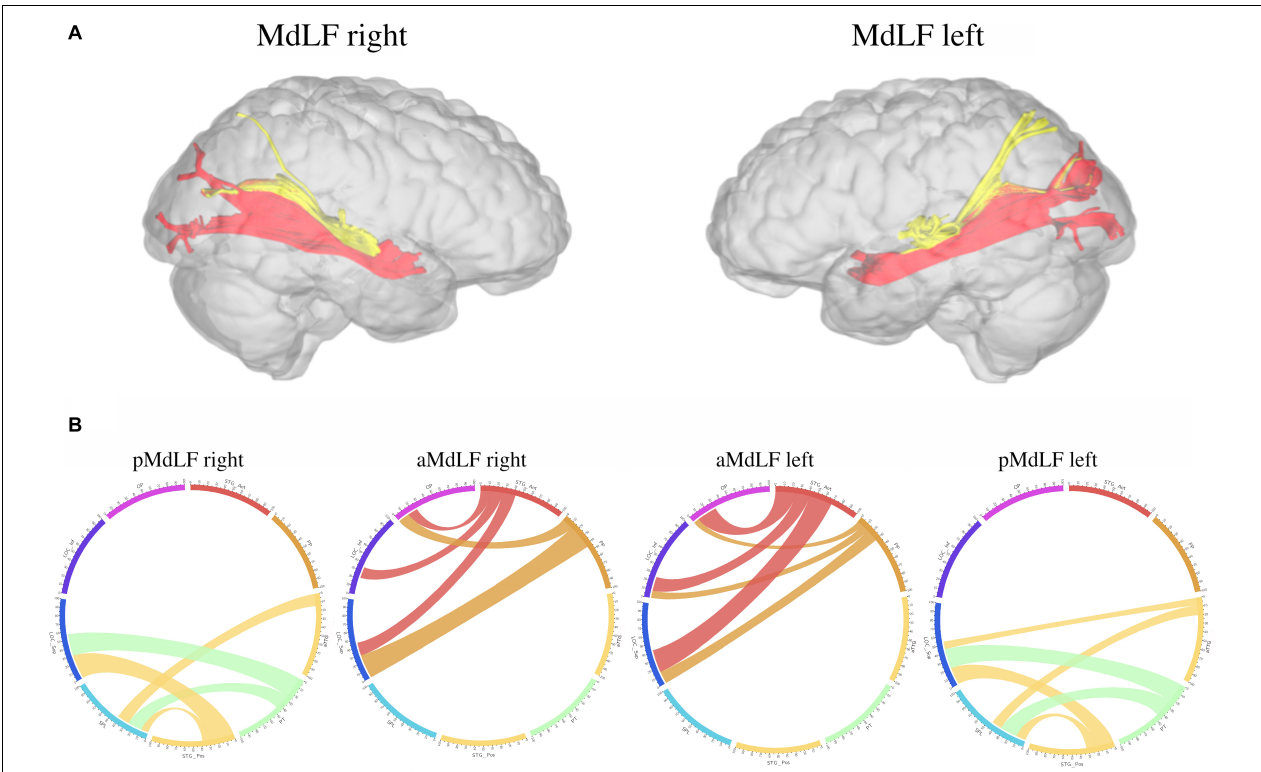
FIGURE 9 | Connectivity analysis at group level for the two subcomponents of the MdLF on both sides, with three-dimensional reconstruction of the illustrative pathways (A) and a circle diagrams to show the connectivity between the selected regions from the Harvard-Oxford Cortical Atlas (B) . The number associated to the cortical areas define the normalized number of streamlines (percentage) connecting the two regions with a cut-off of 3%. The aMdLF (red) was found to connect the anterior portion of the superior temporal gyrus (aSTG) and the PP on both sides with the occipital region only. Within the occipital region, three areas where consistently connected by the aMdLF: the superior portion of lateral occipital cortex (sLOC), which received 40% of the fibers on the left side and 45% on the right side; the inferior portion of lateral occipital cortex (iLOC), with 25% on the left side and 10% on right side; and the occipital pole (OP) receiving 25% of the fibers on the right side and 32% on the left side. The pMdLF (yellow) displayed a constant connection between the posterior portion of the superior temporal gyrus, the anterior temporal transverse gyrus (aTTG) and planum temporale (PT) with the parieto-occipital region. Fibers from the aTTG were found in connection with the superior parietal lobe (SPL) bilaterally (10% on the left side and 15% on the right side) and with sLOC on the left side only (10%). The PT displayed a connection with the SPL bilaterally (20% on the left side, 15% on the right side) and with the sLOC (25% on the right side and 22% on the left side). The posterior portion of the superior temporal gyrus (pSTG) displayed bilateral connections with the SPL (10% on the left side, 8% on the right side) and with sLOC (20% on the left side, 30% on the right